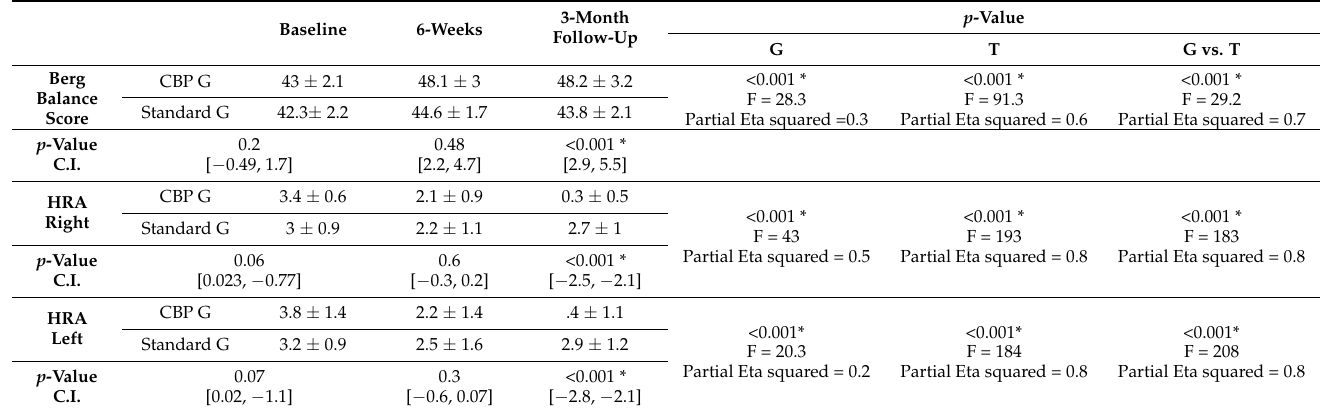
Table 3. The changes in the Berg balance score for balance assessment and HRA in both groups vs. time. CBP = CBP group; standard: standard exercise group; HRA = head repositioning accuracy;